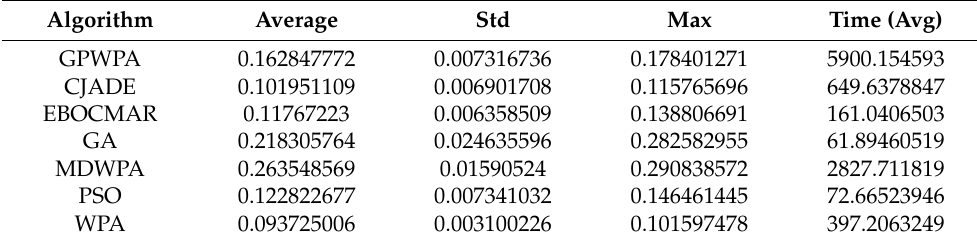
Table 7. The experimental results of variance